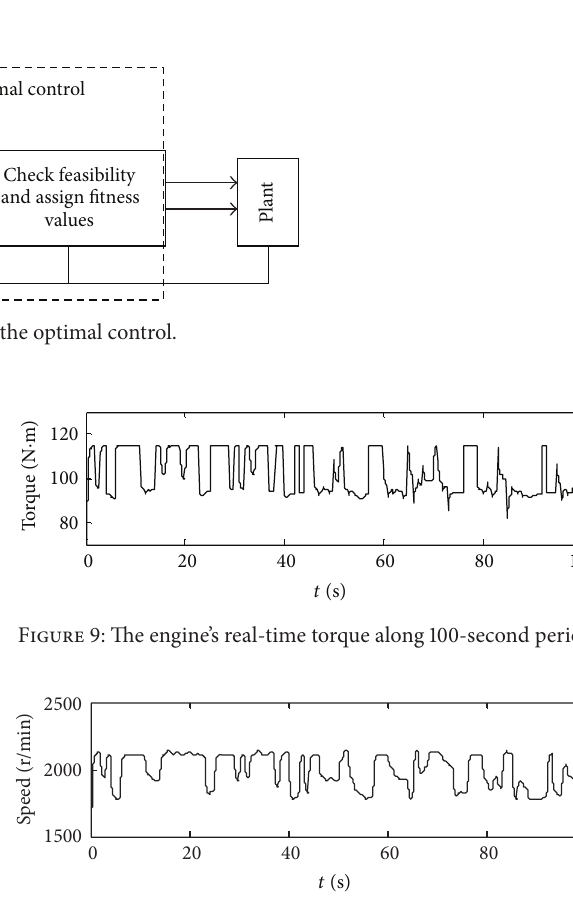
Figure 10: The engine’s real-time speed along 100-second period.